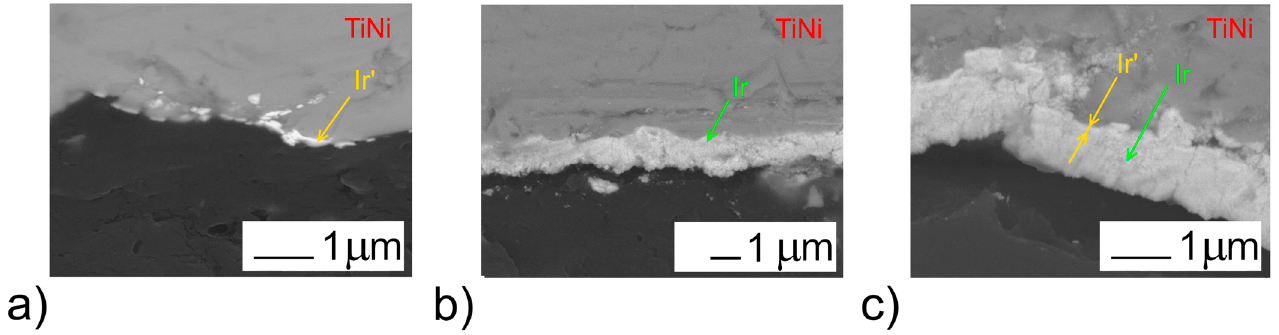
Figure 9. SEM micrographs of the cross-sections of TiNi coated with iridium films: ( a ) Ir’/TiNi; ( b ) Ir/TiNi; and ( c ) Ir/Ir’/TiNi.